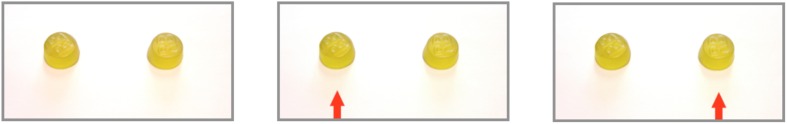
An example of a critical trial. The trial started and ended with the left picture. In between, the middle and right pictures were presented (highlighting the left and right sweet).